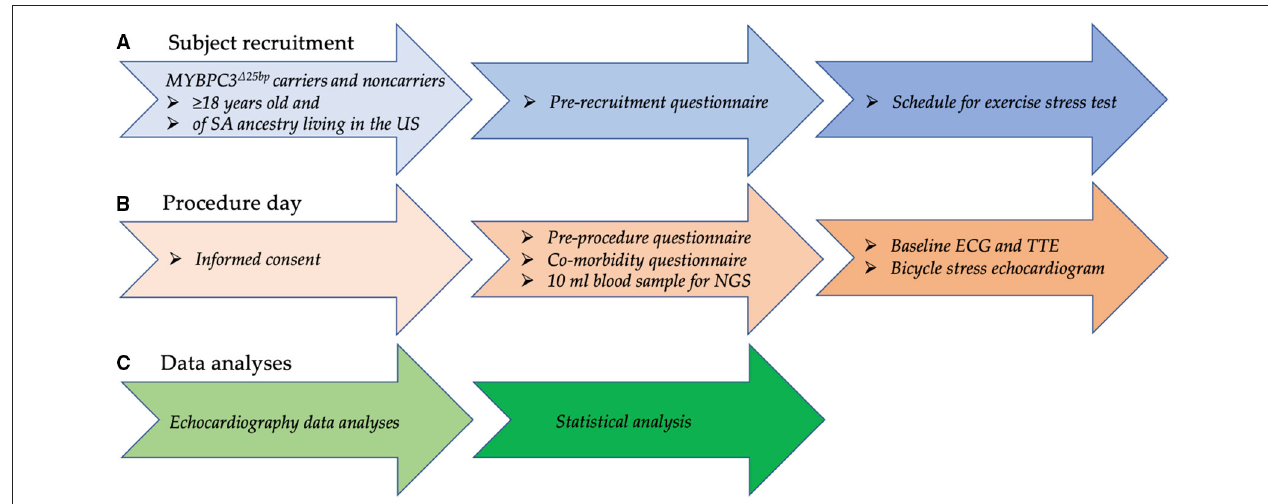
FIGURE 2 | Flow chart depicting the recruitment process, employed questionnaires, and echocardiography and clinical data analyses for the genotype-phenotype study. (A) Carriers of MYBPC3 1 25bp variant and age- and gender-matched non-carriers 18 years of age and older of US SA ancestry were recruited. Then, past medical and medication history was collected using a prerecruitment questionnaire, and, if no contraindication, subjects were scheduled to perform an exercise stress test using a bicycle ergometer. (B) On the test day, informed consent was obtained; then, a comorbidity questionnaire was used to collect comprehensive medical, medication, social, habit, and family history information from all participants. To look for other genetic modifiers via NGS testing, a 10-ml blood sample was collected. Compliance with exercise stress test instructions was evaluated via a pre-procedure questionnaire. Cardiac function was evaluated by ECG and TTE at rest and by bicycle ergometer during exercise stress testing for any detectable underlying risk factor. (C) While blinded, two observers independently measured echocardiography variables. Statistical significance ( p < 0.05) was calculated using two-way ANOVA and simple linear regression, and the results were reported as mean ± SEM. SA = South Asian, NGS = next-generation sequencing. TTE, transthoracic